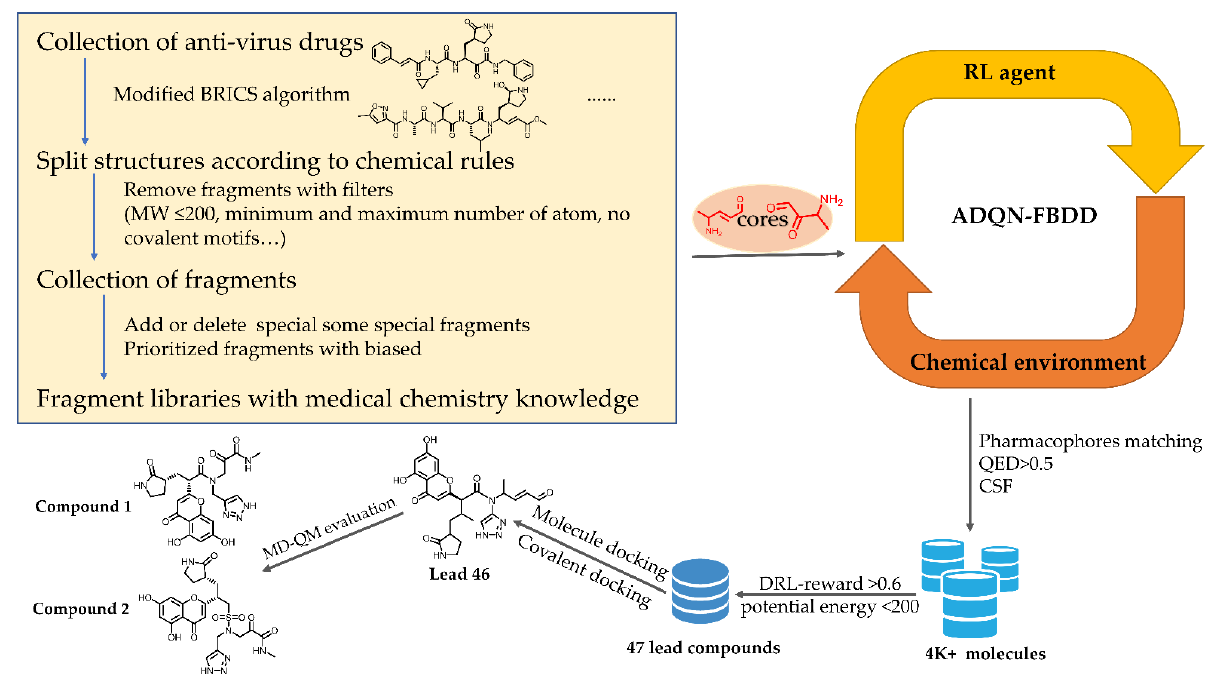
Figure 1. Art for SARS-CoV-2 3CL pro lead compound